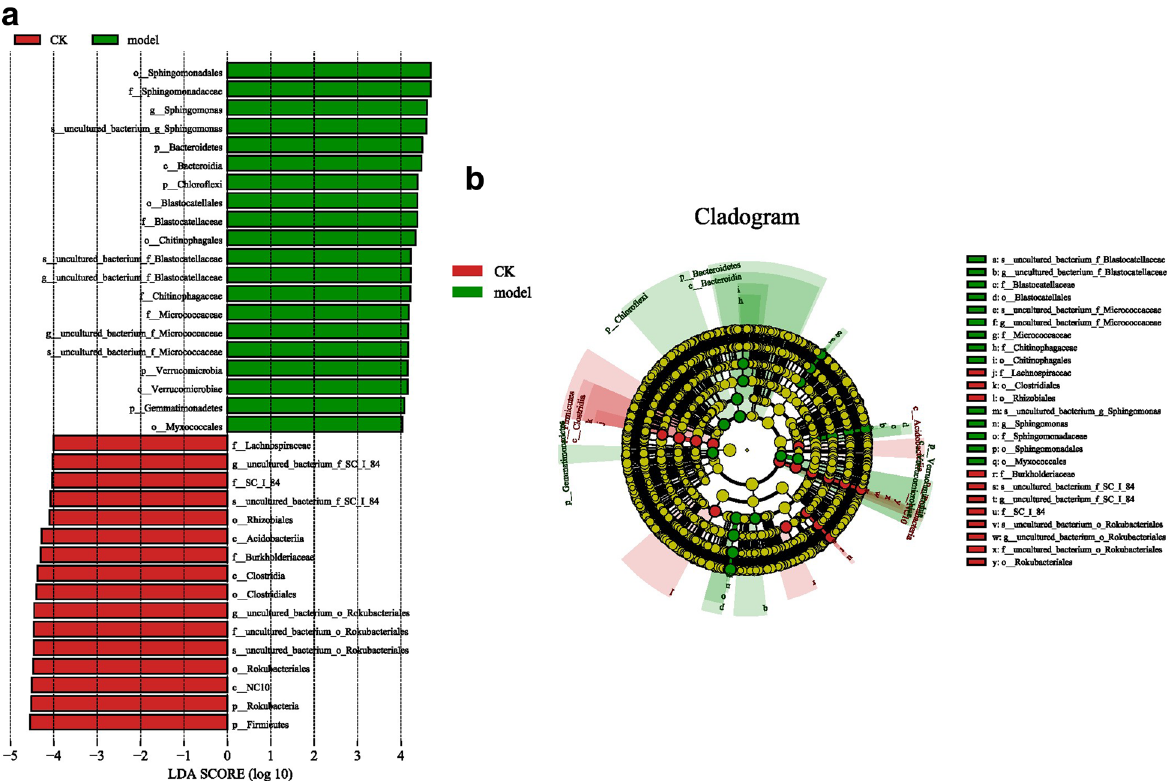
Fig. 6 Indicator microbes in groups with linear discriminant analysis (LDA) scores higher than 4. a LDA score of LDA effect size (LefSe). Evolutionary branch diagram of differential bacterial communities or species. b Cladogram of LEfSe. The size of the circle from inside to outside of the evolutionary branching graphs in a group indicates the importance of abundance from the phylum to genus or species levels, and groups with the same color indicate the importance of the phylum in this group. The LDA value (influence value of linear discriminant analysis) distribution histogram shows the bacterial community or species (biomarker) with LDA scores > 4. All the displayed bacterial communities or species exhibited significant differences among all groups. The letters k, p, c, o, f, g, and s indicate kingdom, phylum, class, order, family, genus, and species, respectively. Bacterial communities or species with significant abundance differences in different groups are shown, and the length of the histogram represents the influence of the